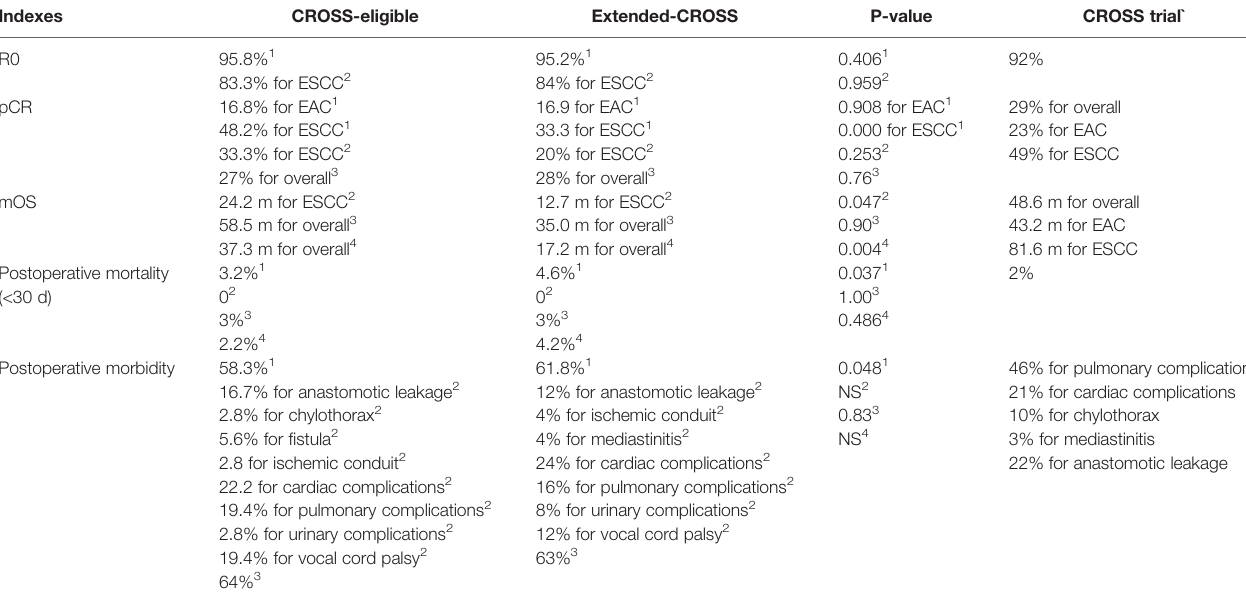
TABLE 6 | Comparison of ef fi cacy of CROSS regimen in real-world scenario versus clinical trial.